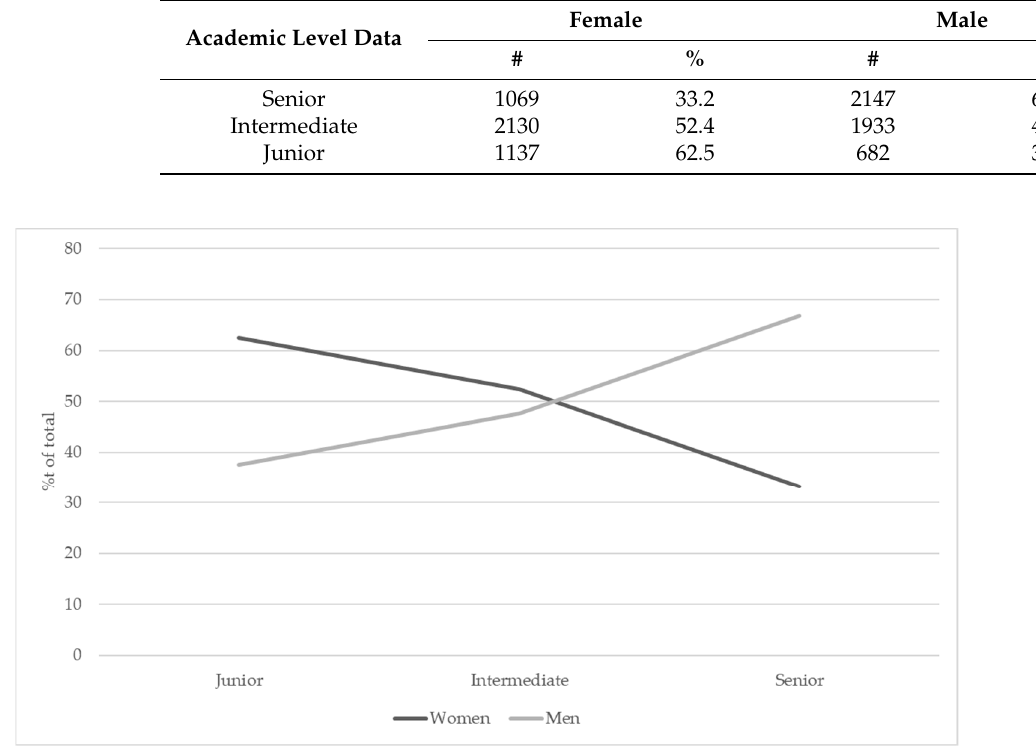
Table 6. General gender distribution across different academic levels in the Europe region.